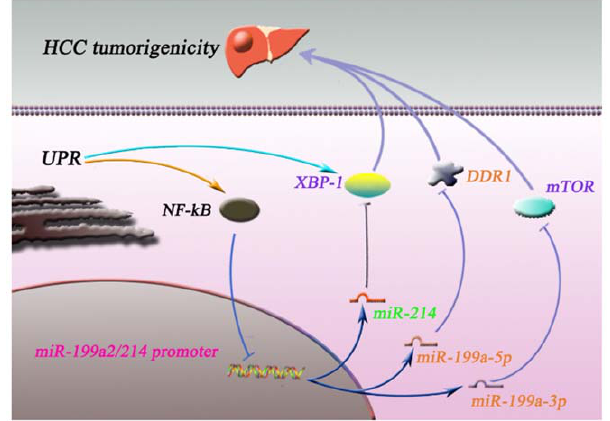
Figure 7. Summary diagram describes the ER stress/NF k B/miR- 199a/214 network that regulates HCC tumorigenicity. The miR- 214/XBP-1 pathway was shown in this work, while miR-199a-3p/mTOR and miR-199a-5p/DDR1 pathways were reported by other studies.